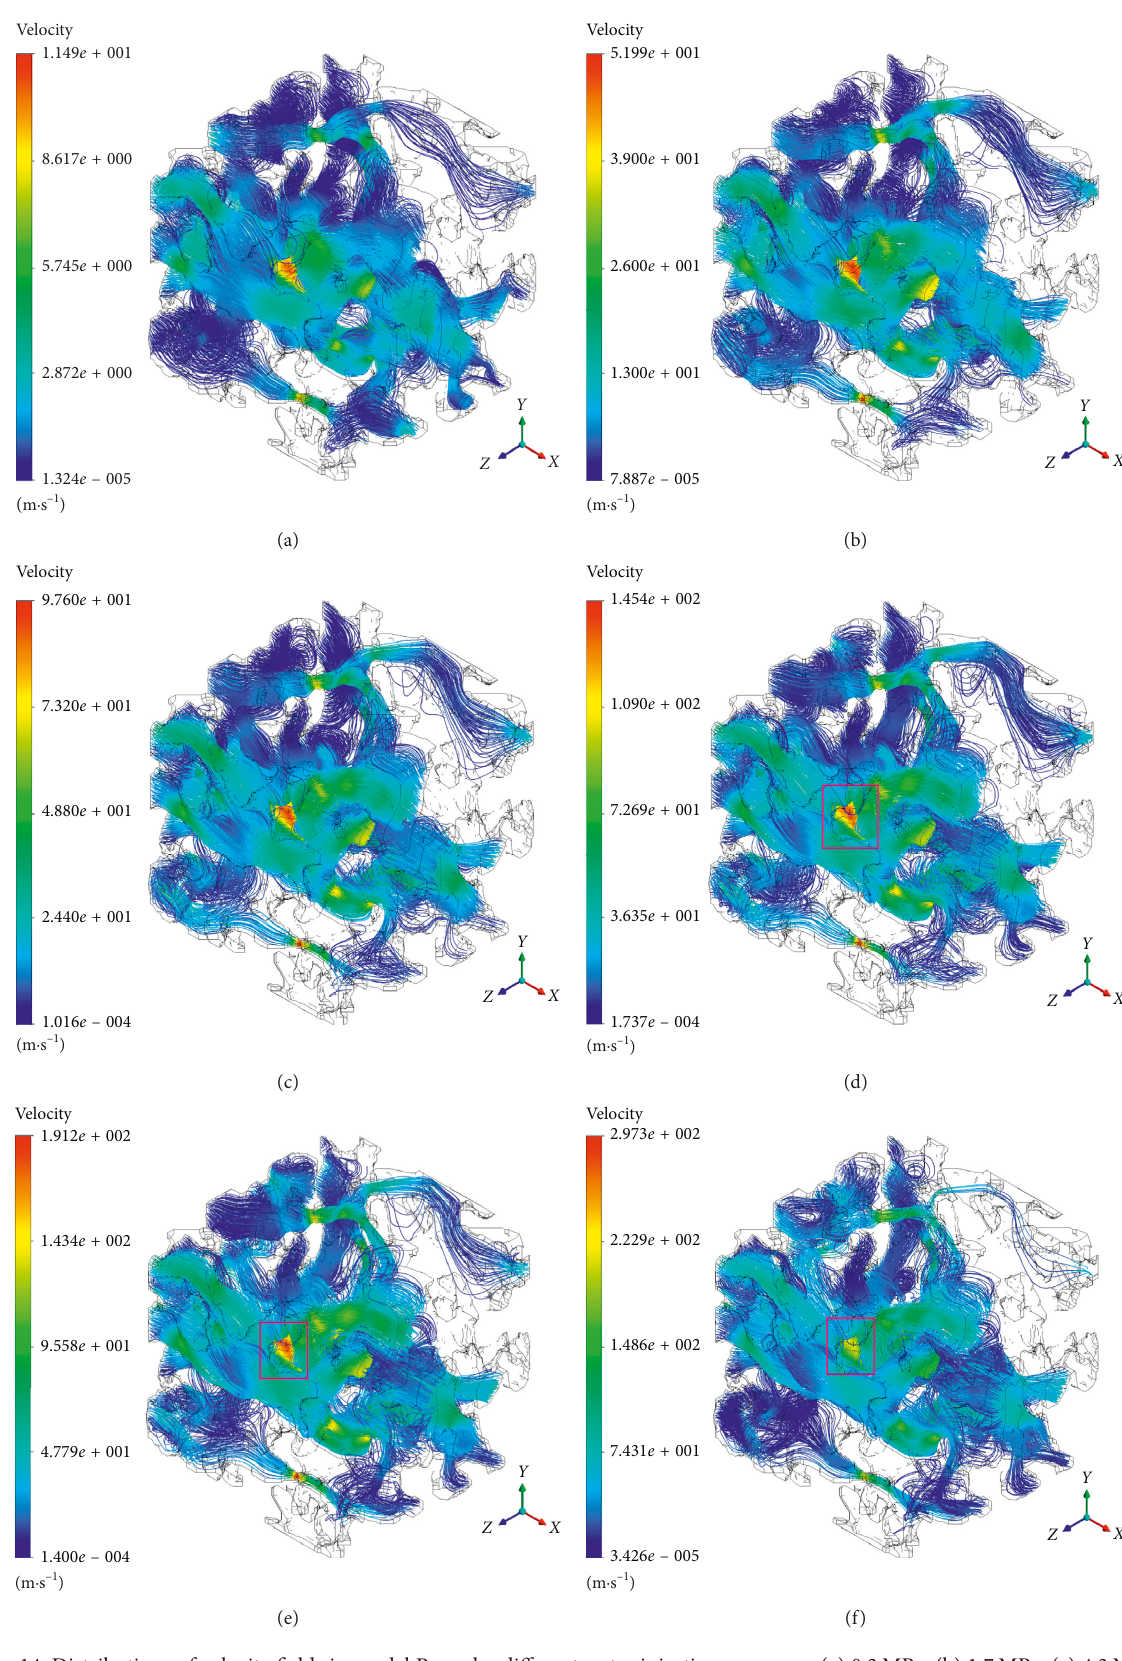
Figure 14: Distributions of velocity fields in model P 1 under different water injection pressures. (a) 0.3MPa. (b) 1.7MPa. (c) 4.3 MPa. (d) 8.1MPa. (e) 13.1MPa. (f)